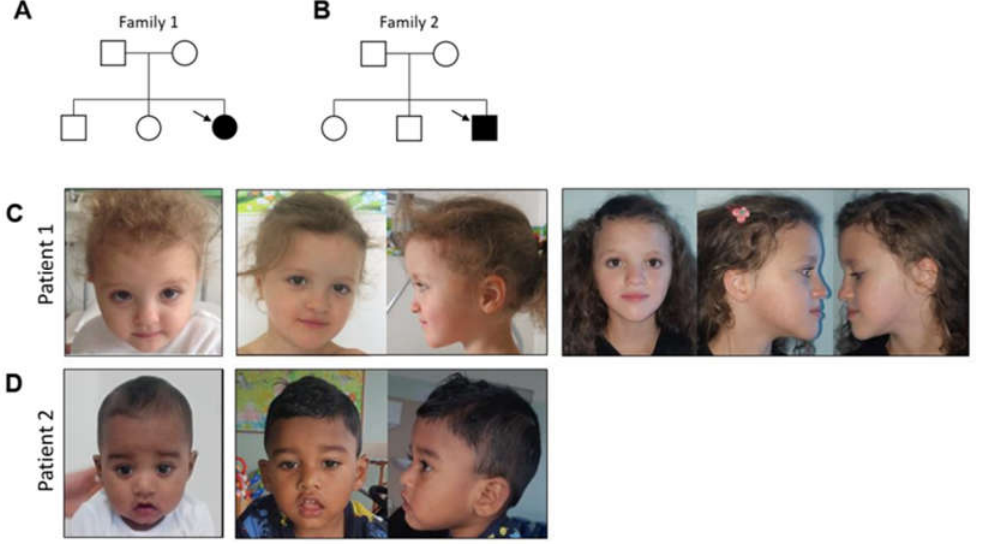
Figure 1. ( A , B ) Pedigrees of the two families included in the study. Square, male; circle, female; filled, affected; unfilled, unaffected; arrows indicate index patients. ( C ) Dysmorphic craniofacial features (front and side views) of patient 1 at 27 months (left panel), 5 years and 7 months (middle panels) and 11 years (right panels). ( D ) Dysmorphic craniofacial features (front and side views) presented by patient 2 at 8 months (left panel) and 26 months of age (right panels).